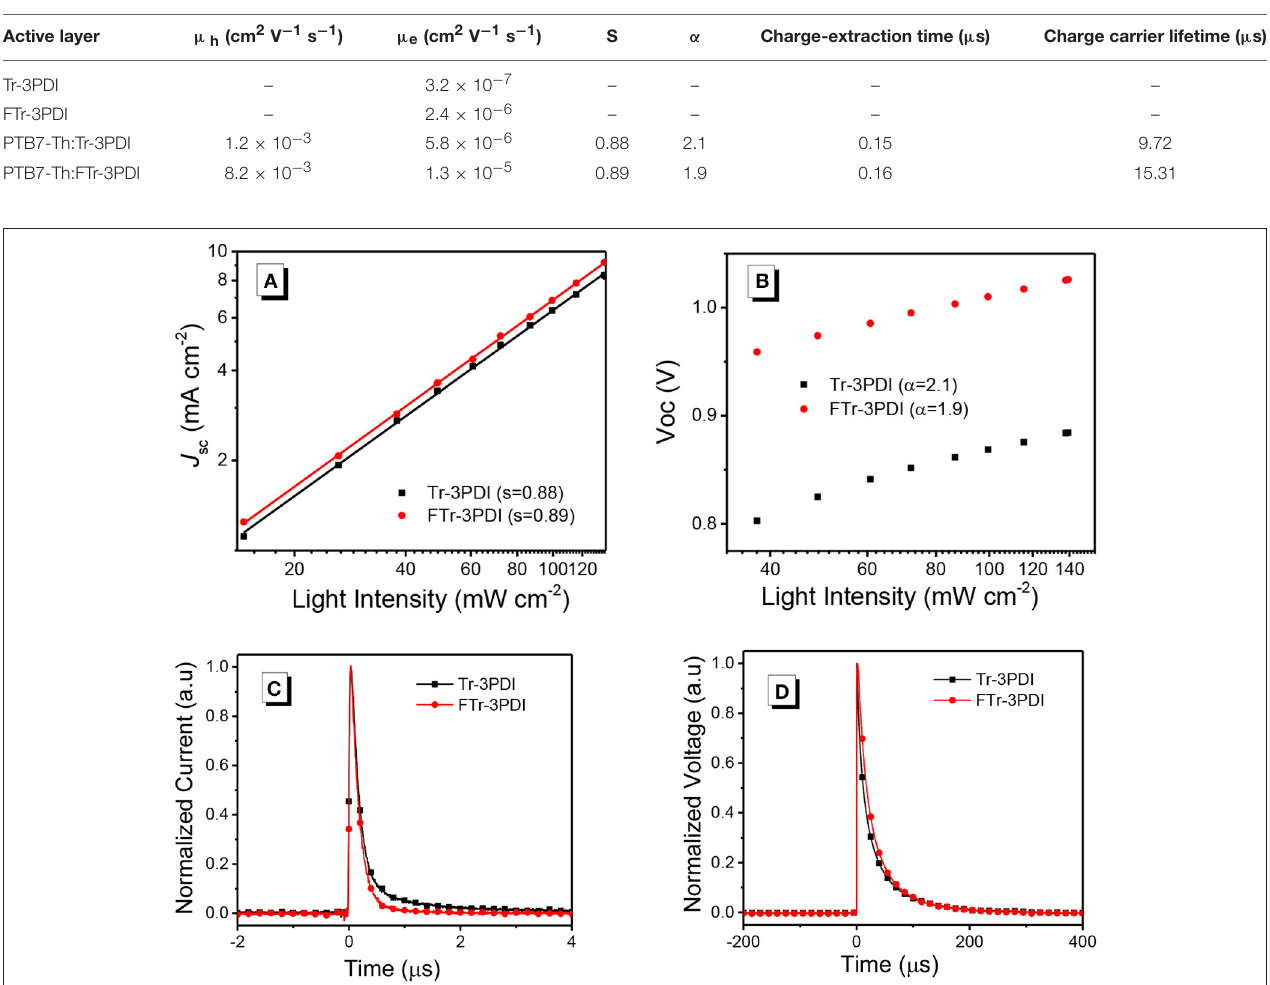
TABLE 3 | The relevant parameters related to charge transport and recombination of PTB7-Th: truxene-PDI acceptor devices. Active layer